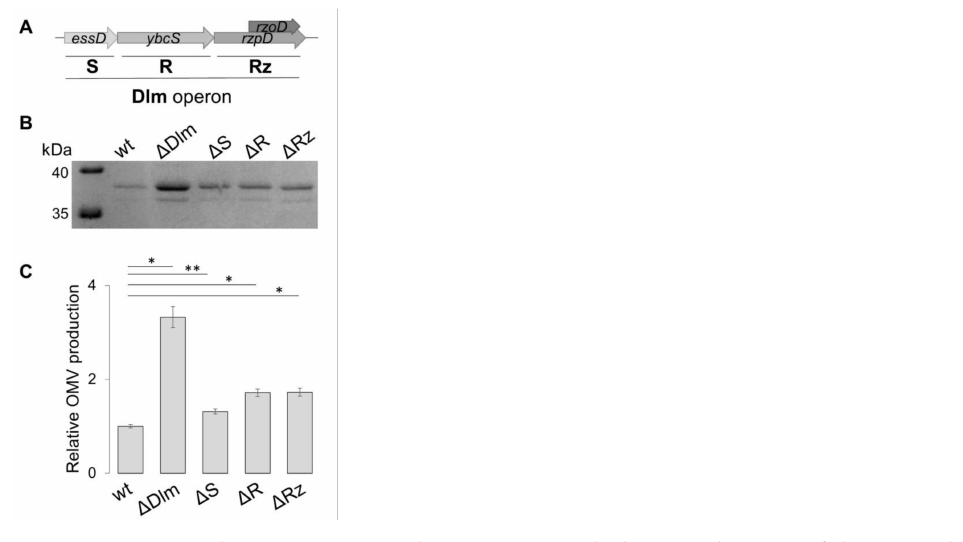
Figure 4. OMV production in ULS153 derivative strains lacking single genes of the DLP12 lysis module. ( A ) Schematic representation of the SRRz/Rz1 (Dlm) operon. Four genes are present: essD , encoding the holin (S); ybcS encoding endolysin (R); and rzpD/rzoD encoding the spannins (Rz). ( B ) SDS-PAGE separation of OMV proteins from ULS153 (wt) and its derivatives lacking the entire DLP12 lytic module ( ∆ Dlm), the essD gene ( ∆ S), the ybcS gene ( ∆ R), or the rzpD / rzoD genes ( ∆ Rz). ( C ) OMV production by ULS153 ∆ Dlm, ∆ S, ∆ R or ∆ Rz normalized to the wt. OMV amount was obtained by densitometry of the OmpF/C band in SDS-PAGE separations. Vertical bars indicate the standard deviation of three independent experiments. Statistical significance was determined by the t test, and p values are as follows: * p < 0.01, ** p < 0.05.